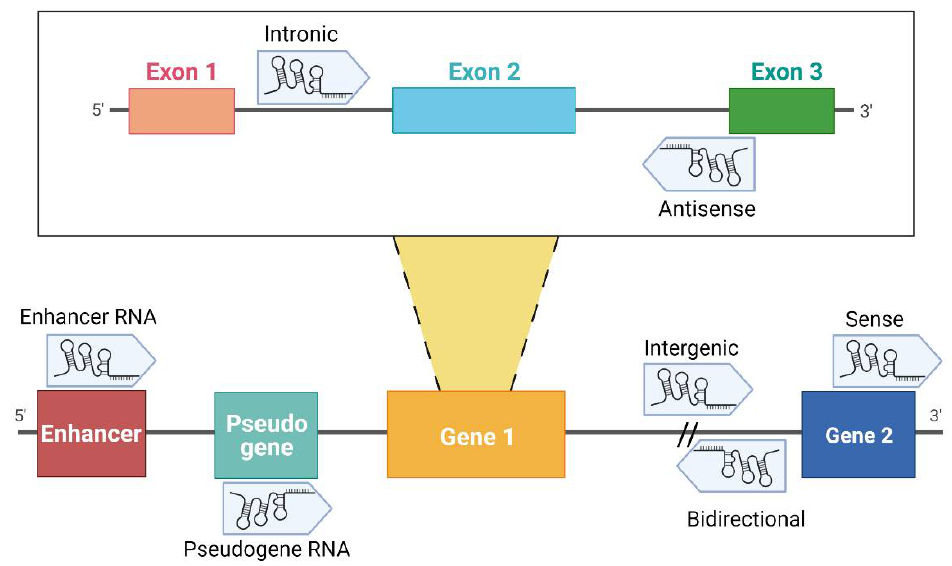
Figure 1. Classification of lncRNAs according to their genome localization. Intronic: the sequence originates from an intron region of a protein-coding gene [19]. Antisense: transcribed from the antisense strand of a gene sequence, originating from an exon or intron region [20]. Enhancer RNA (eRNA): RNA transcribed from transcriptional enhancer. eRNAs could present polyadenylation and 5′ cap. Generally, they are unstable with a short half-life [21,22,23]. Pseudogene RNA: the transcripts originated from pseudogene and could be short or long ncRNAs [24,25]. Intergenic: the localization is in an intergenic region, precisely more than 1 kb away from closest genes [20,22,26]. Bidirectional: the sequence is mainly located on the opposite strand with respect to a gene, of which transcription starts less than 1000 bp away [26,27,28]. Sense: this kind of lncRNA is transcribed from the sense strand and contains exons of protein-coding genes [29]; some are variants of mRNAs, while others do not contain a functional open reading frame [28]. Created with BioRender.com (accessed on 9 April 2021).